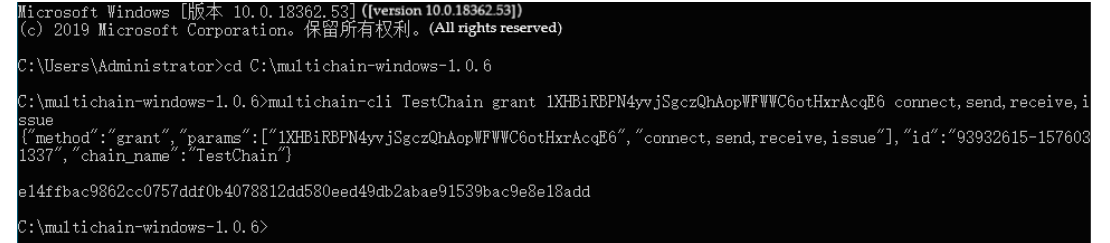
Figure A3. Setting the permissions of the slave node.